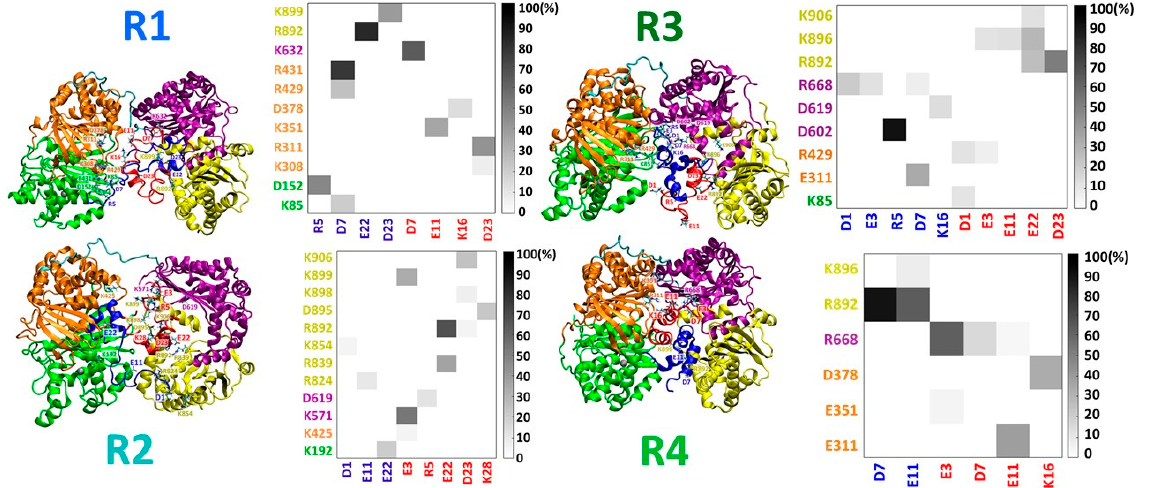
Figure 2. Final simulated structures of IDE-A β random coil/ α -helix dimer and electrostatic interac- tion contact maps (measured by the occurrences in percentages along the MD simulations) between residues within the IDE domains (domain 1: green; domain 2: orange; domain 3: purple; domain 4: yellow) and A β monomers within the dimer for models R1 (top left), R2 (bottom left), R3 (top right), and R4 (bottom right).